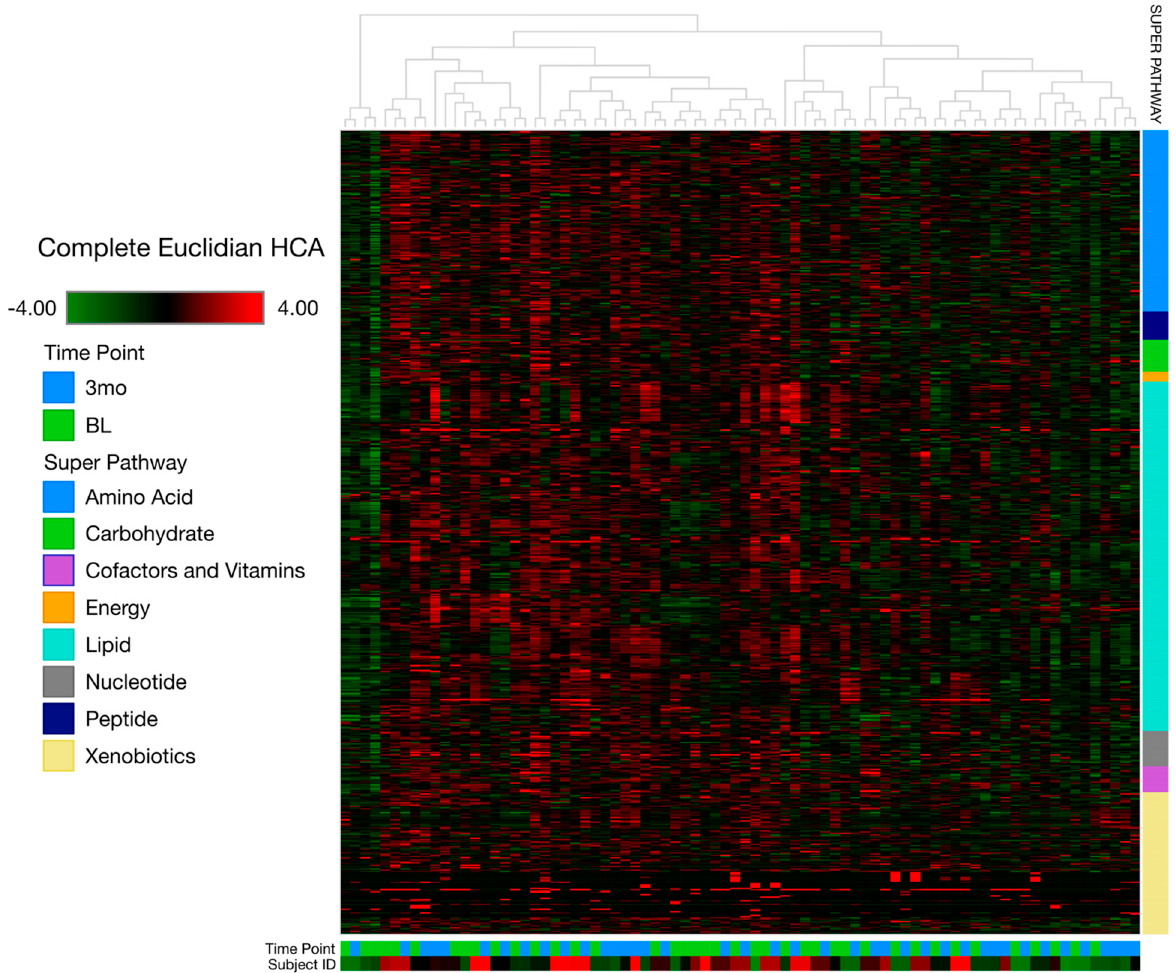
Figure 1. Dendrogram from Hierarchical Cluster Analysis. Baseline and three-month samples from the same subject clustered together in multiple instances. Samples from the same time point had a moderate tendency toward adjacency.